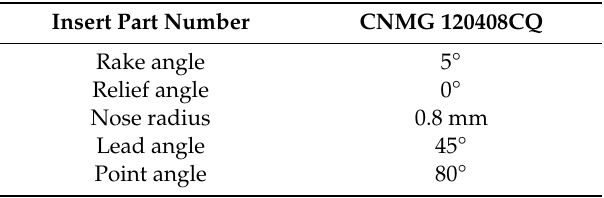
Table 2. Cutting insert specifications.